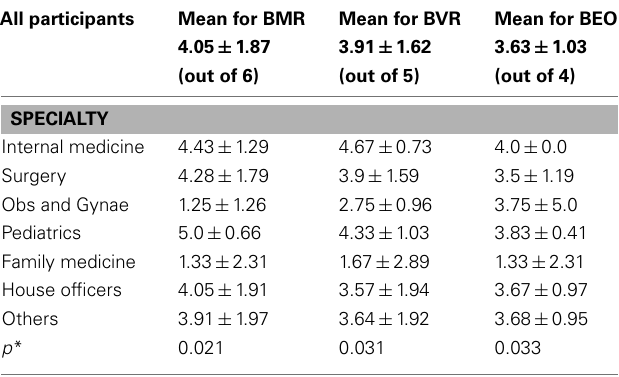
Table 4 | Comparison of mean scores in each clinical variable of GCS by